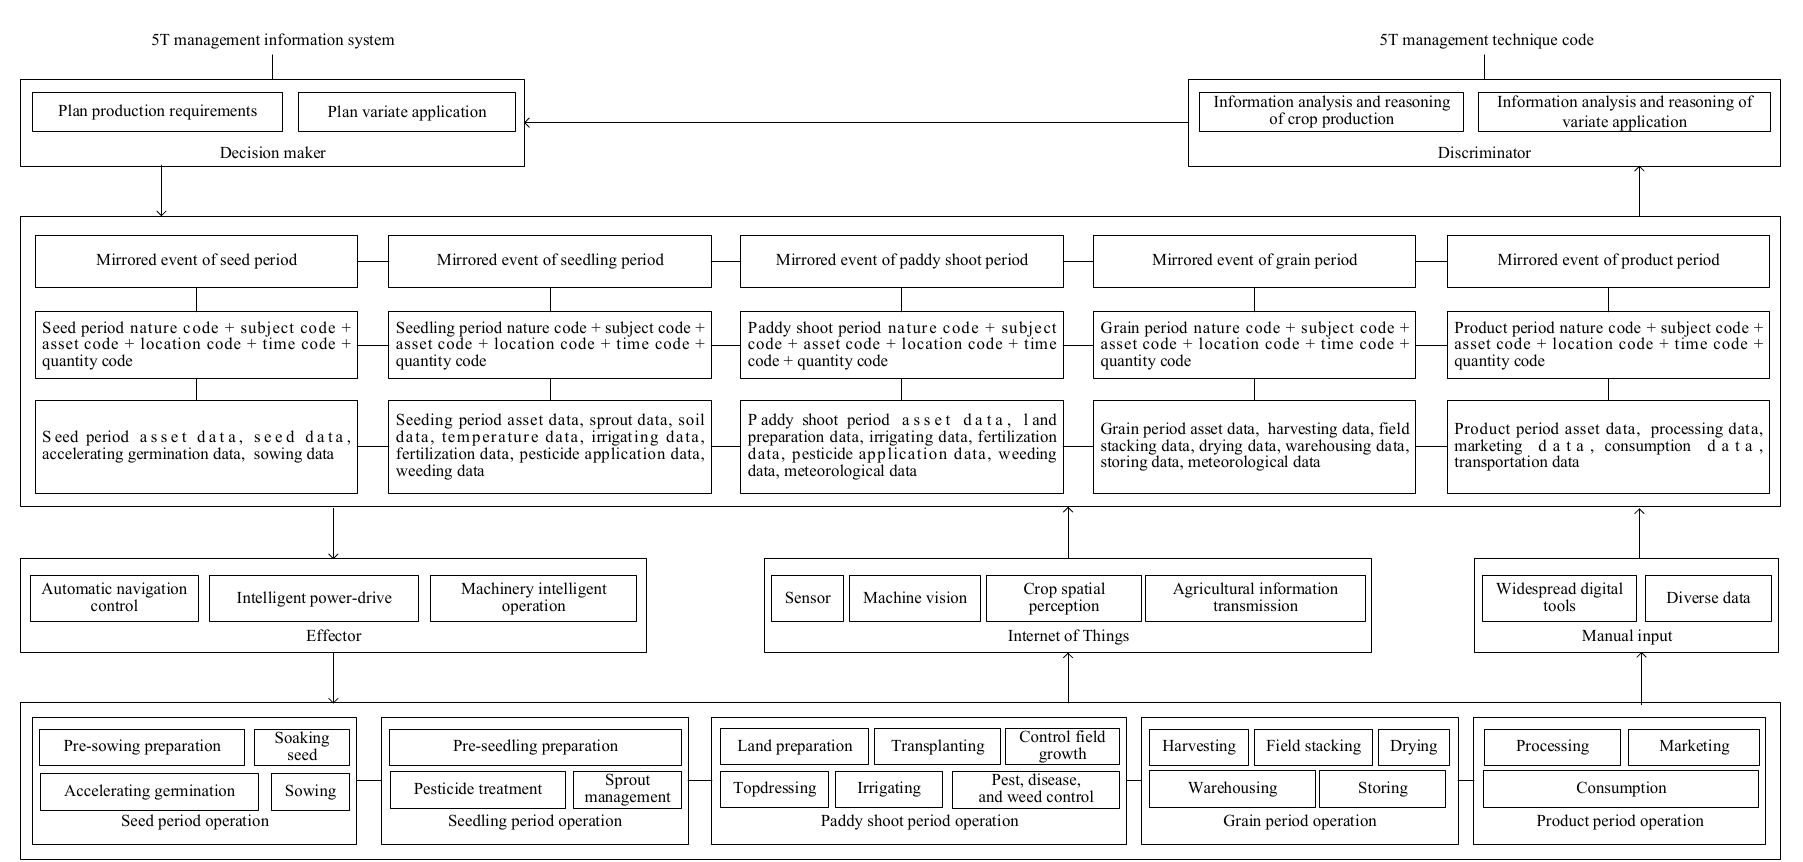
Figure 8. Whole plant 5T management of the Shili Mirrored Structure.